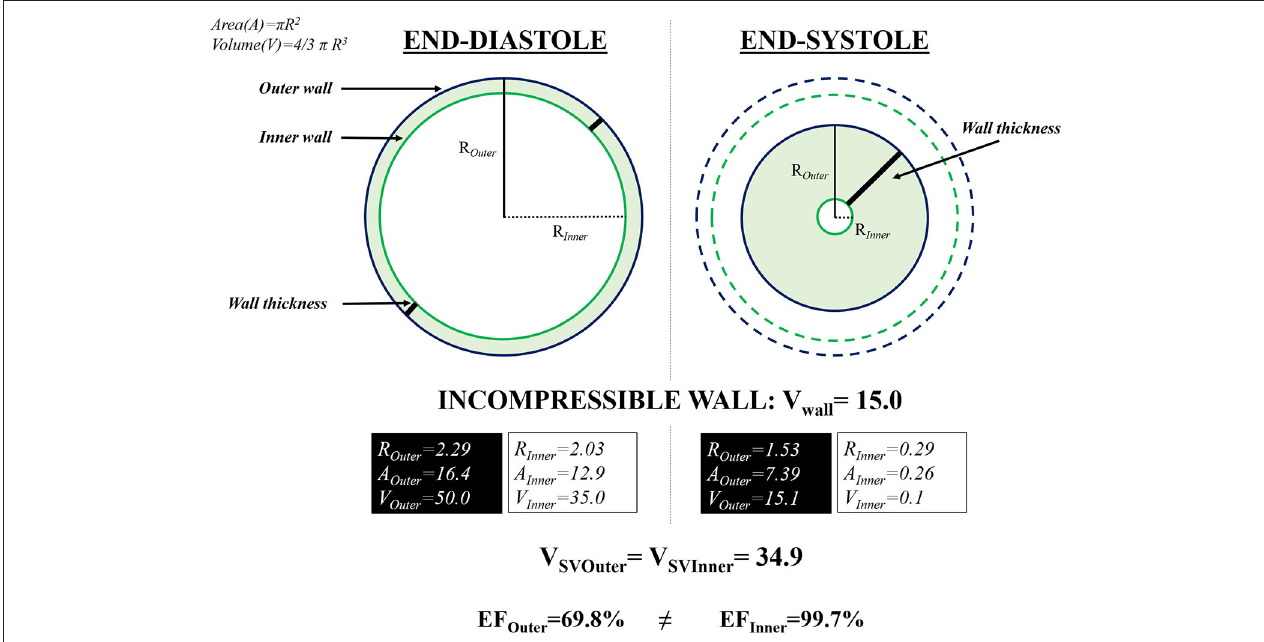
FIGURE 4 | Simple schematic of the ventricle in cross-section, assuming that the ventricular wall can change shape (thickness) and that ventricular tissue is incompressible. Irrespective of whether the inner or outer ventricular wall is used for outlining, calculated stroke volume remains constant. A, area; EF, ejection fraction (%); R, radius or semi-diameter; V, volume; V SV , stroke volume. Adapted and modified from Stoylen (2001) and Stoylen et al. (1999,